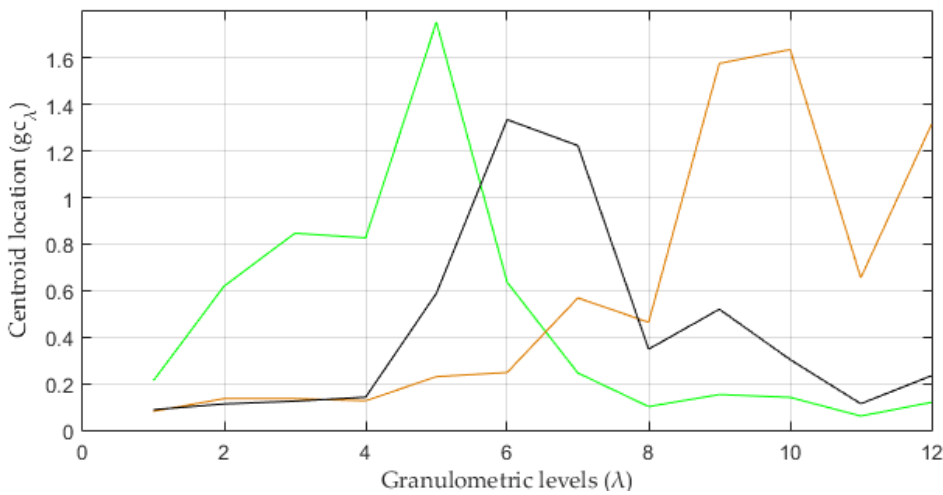
Figure 9. Granulometric profile of nested classification in 3 classes from the green class of Figure 8. Guileyni, 1975.